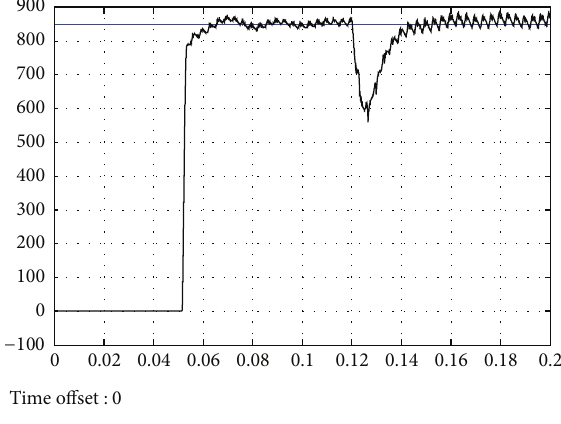
Figure 8: Command current and compensation current. Figure 9: Voltage wave of the DC